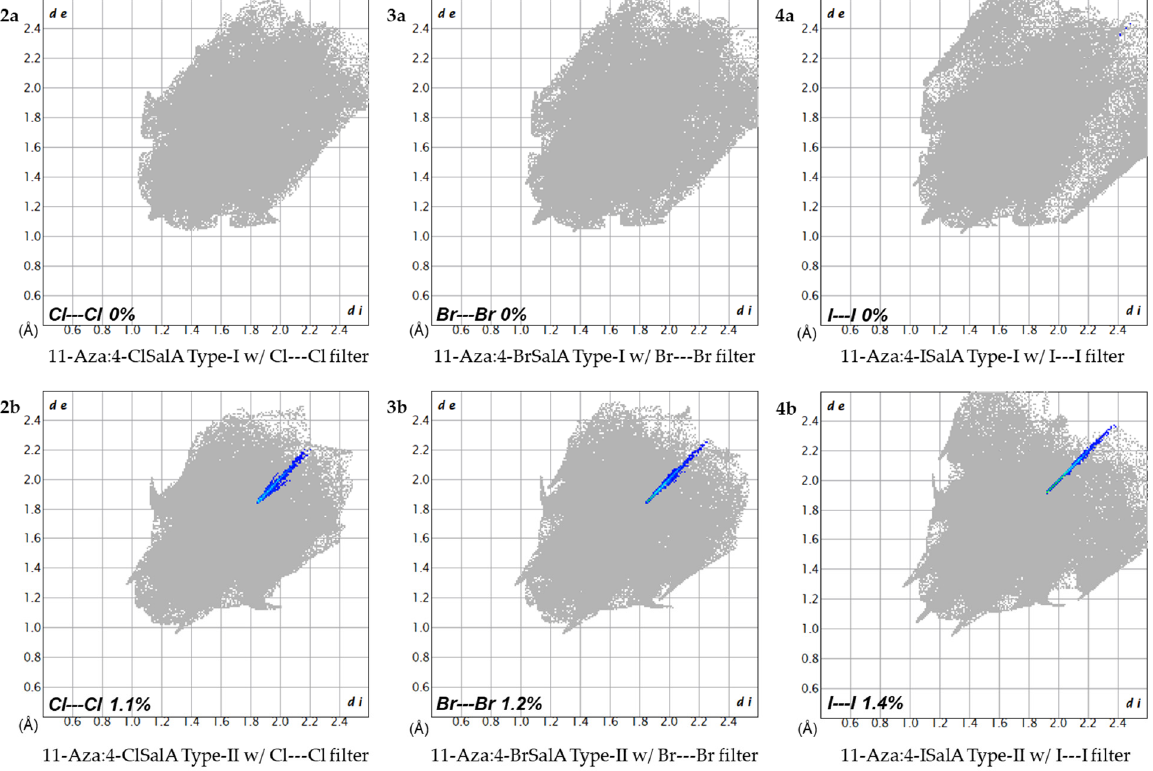
Figure 11. Hirshfeld surface analysis fingerprint plots [29] for Type-I (upper ) and Type-II ( lower ) polymorphs of 11-Aza:4-X-SalA showing absence and presence of X---X interactions ( blue ).